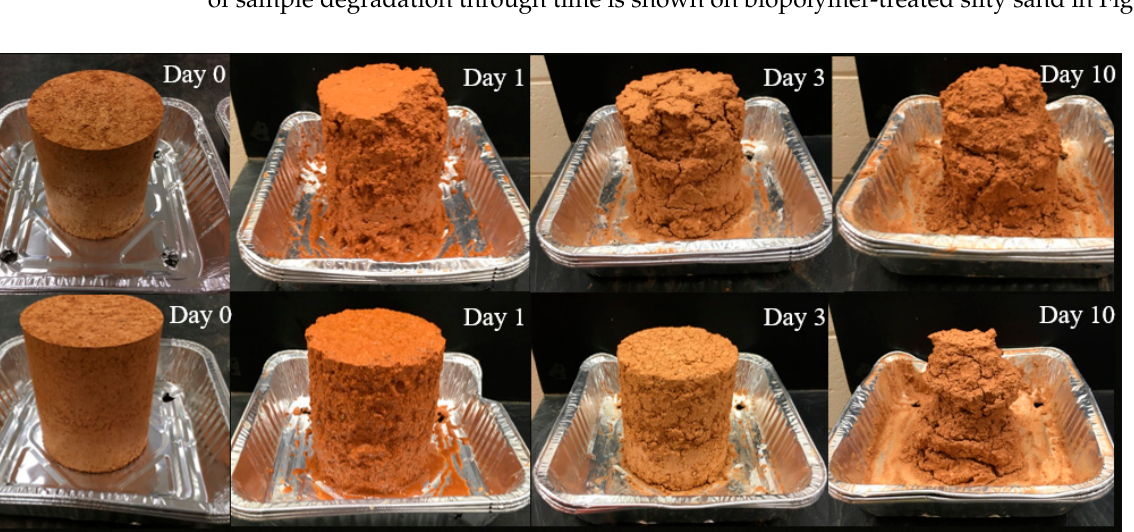
Figure 3. Degradation of silty sand treated with 1% XG ( upper row ) and 1% GG ( bottom row ) due to cyclic wetting and drying.